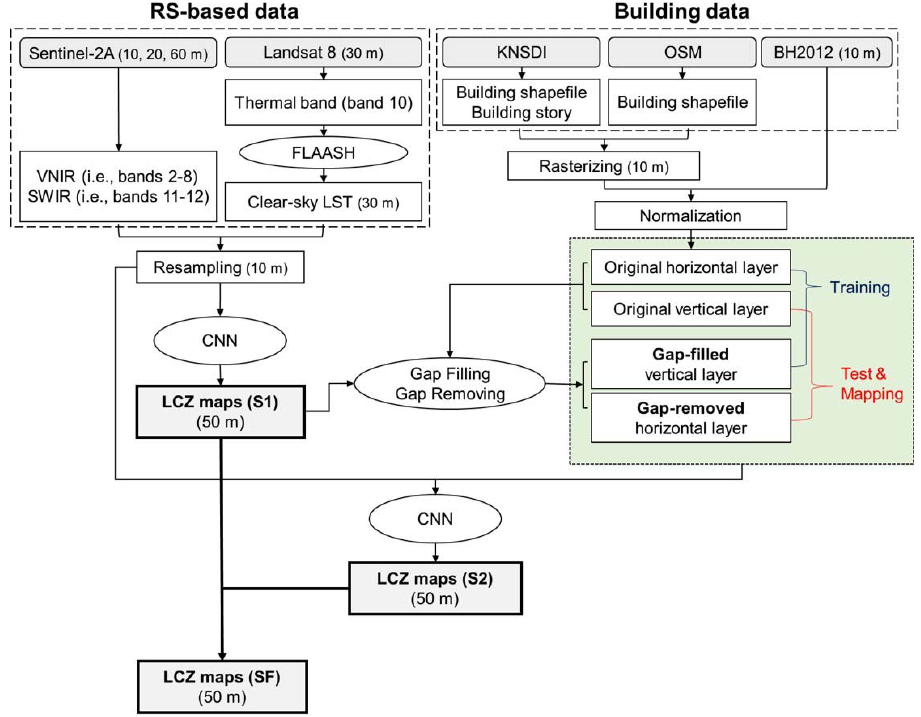
Figure 4. Schematic diagram of this study showing input variables and processes of each scheme.